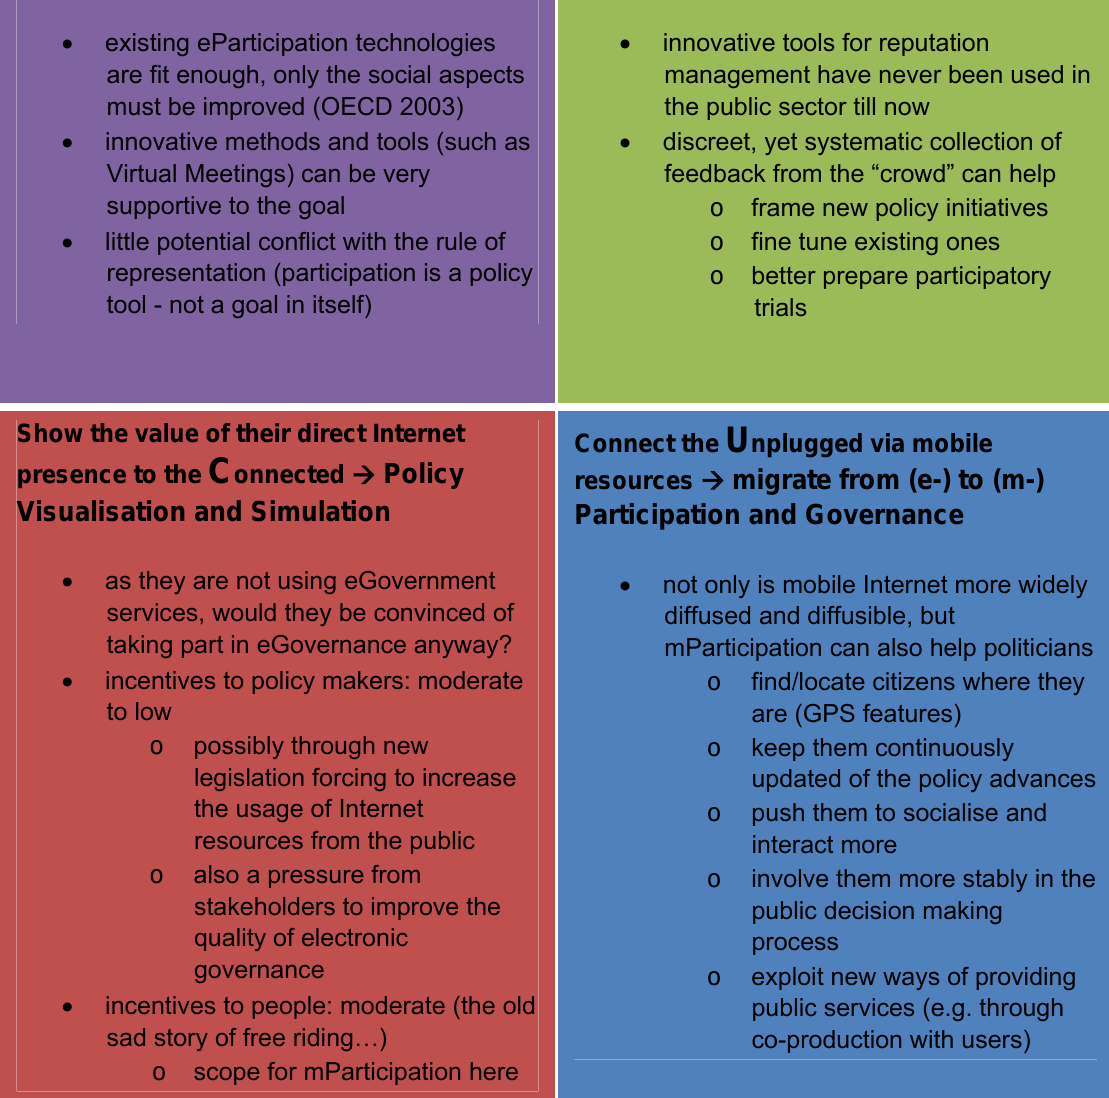
Table 4: Pragmatic implications of the ASCU model for policy makers Exploit the A ctivists for Crowdsourcing of Ideas, Concepts  Policy